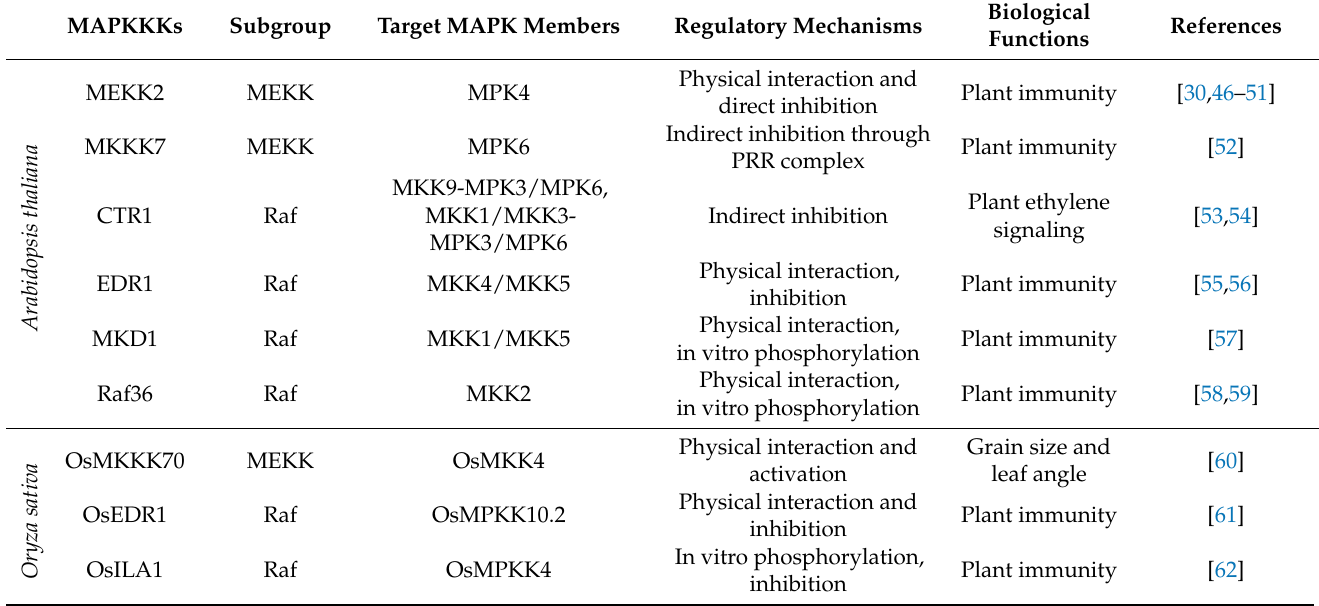
Table 2. Uncanonical regulation of MAPK members by MAPKKKs in